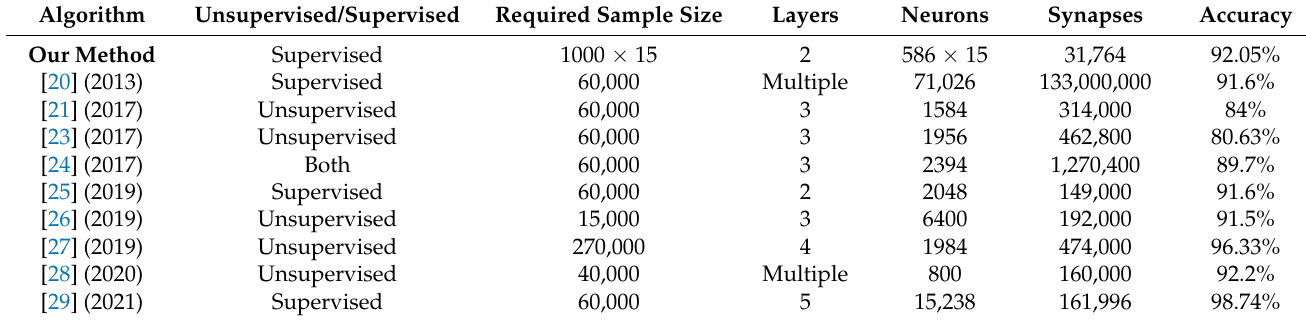
Table 2. Comparison